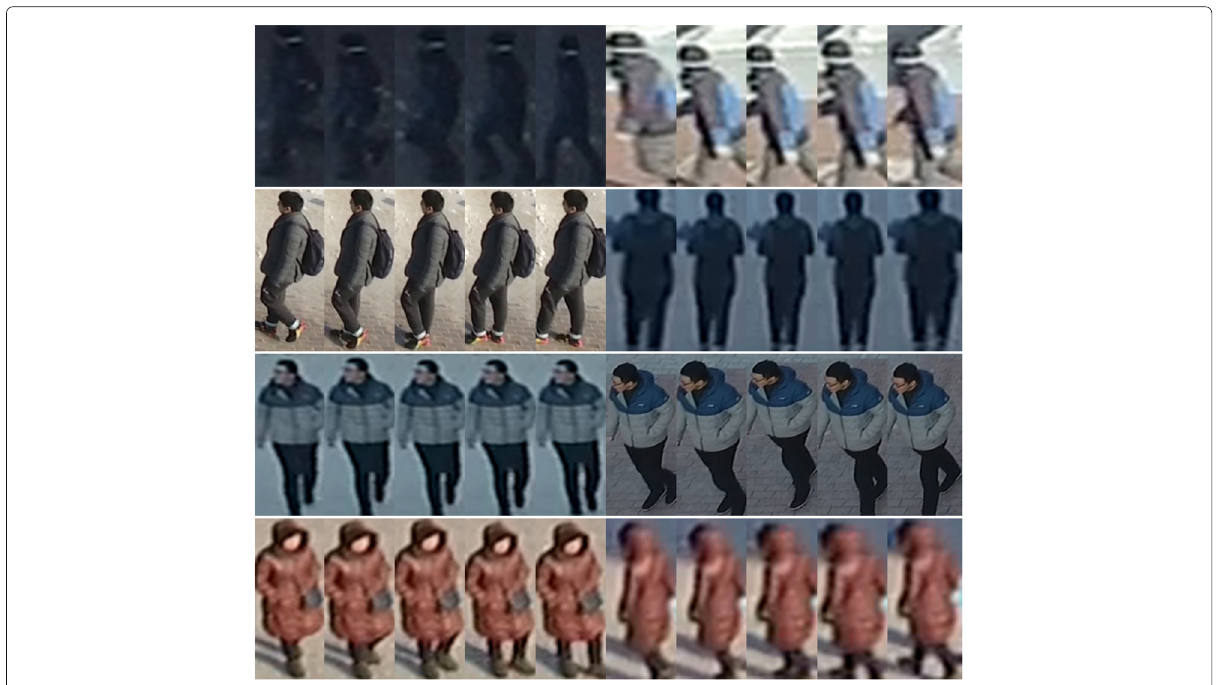
Fig. 2 Examples of pedestrians’ images extracted by the object detector in the DRHIT01